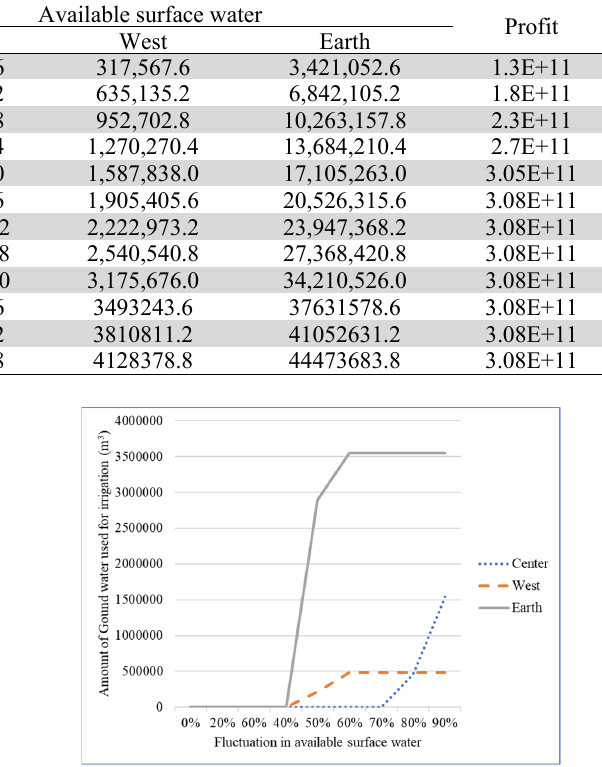
Fig. 6. Groundwater usage vs. the available amount of surface water (SW)